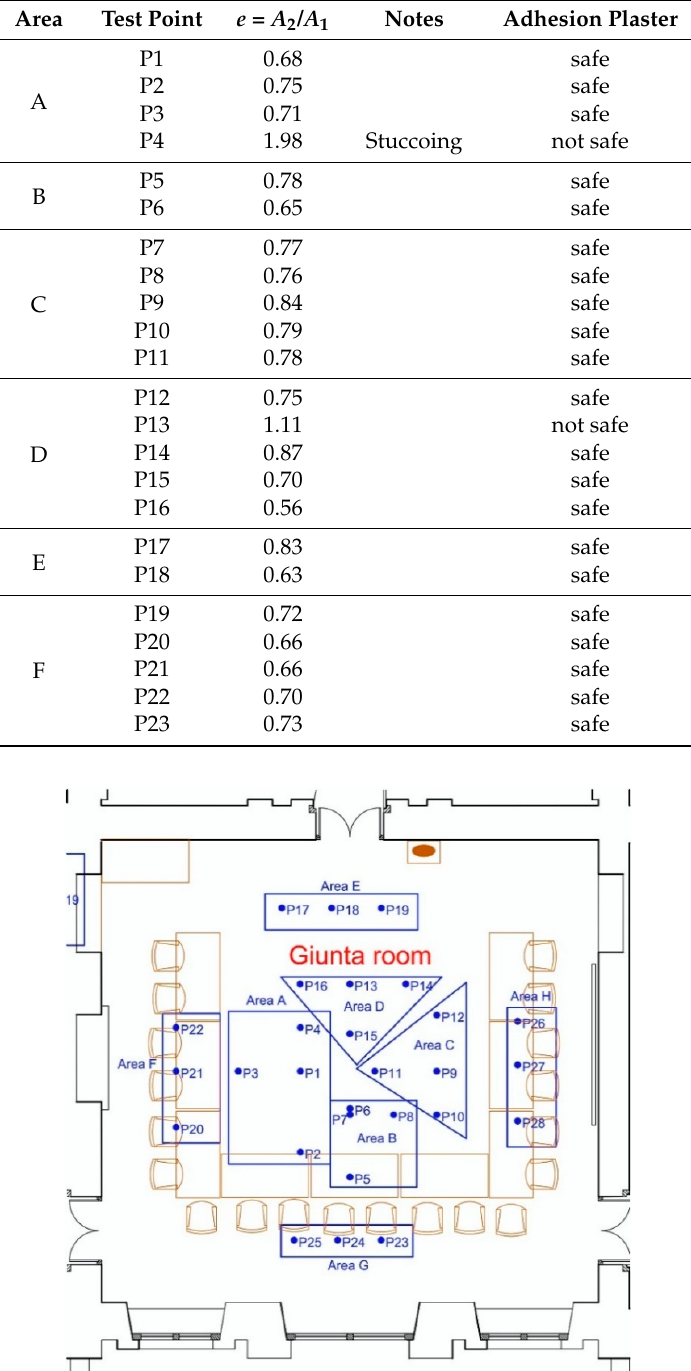
Figure 12. Map of the points and areas tested on the vault of the Giunta room. Table 3. Results of impact test on Giunta room vault.